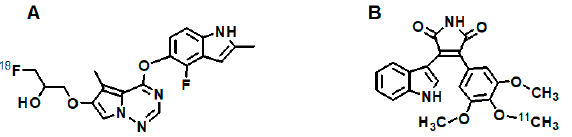
Figure 6. Brivanib-based and diaryl maleimide-based VEGFR imaging agents; ( A ): [ 18 F]F-brivanib